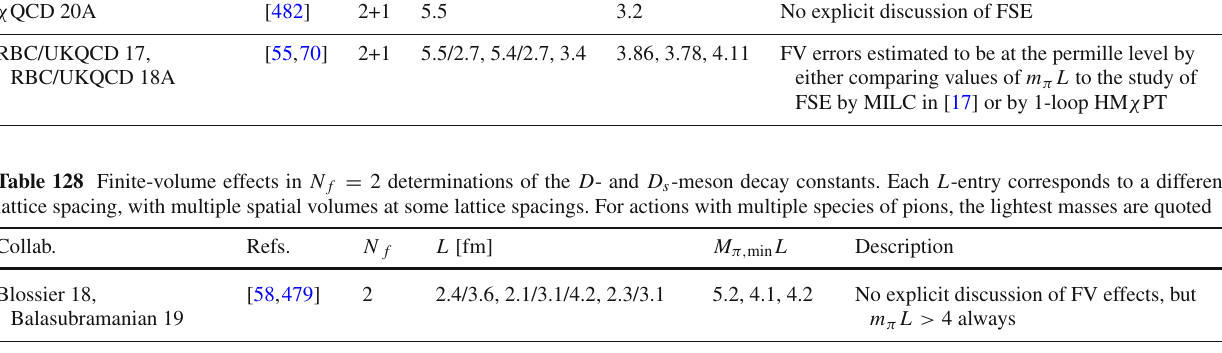
Table 127 Finite-volume effects in N f = 2 + 1 determinations of the D - and D s -meson decay constants. Each L -entry corresponds to a different lattice spacing, with multiple spatial volumes at some lattice spacings. For actions with multiple species of pions, the lightest masses are quoted Collab.